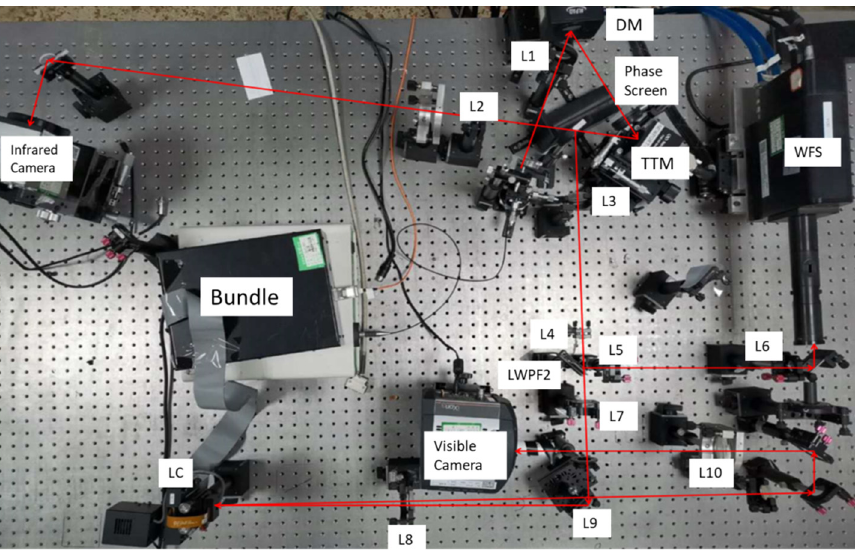
Figure 6. Optical layout of the LC–DM AO system.